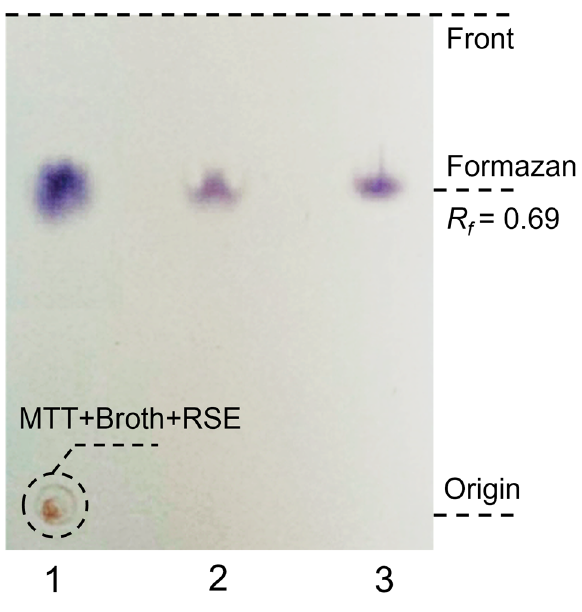
Figure 5. The TLC plate of formazan that was produced from NZ ‘Hass’ ripe avocado seed extract treated in the S. aureus suspension. 1 indicates common method: The formazan dissolved using the acidic isopropanol dissolving method; 2 indicates after fi ltering: The formazan dissolved using the column chromatography fi ltering method; 3 indicates standard: The formazan standard solution.